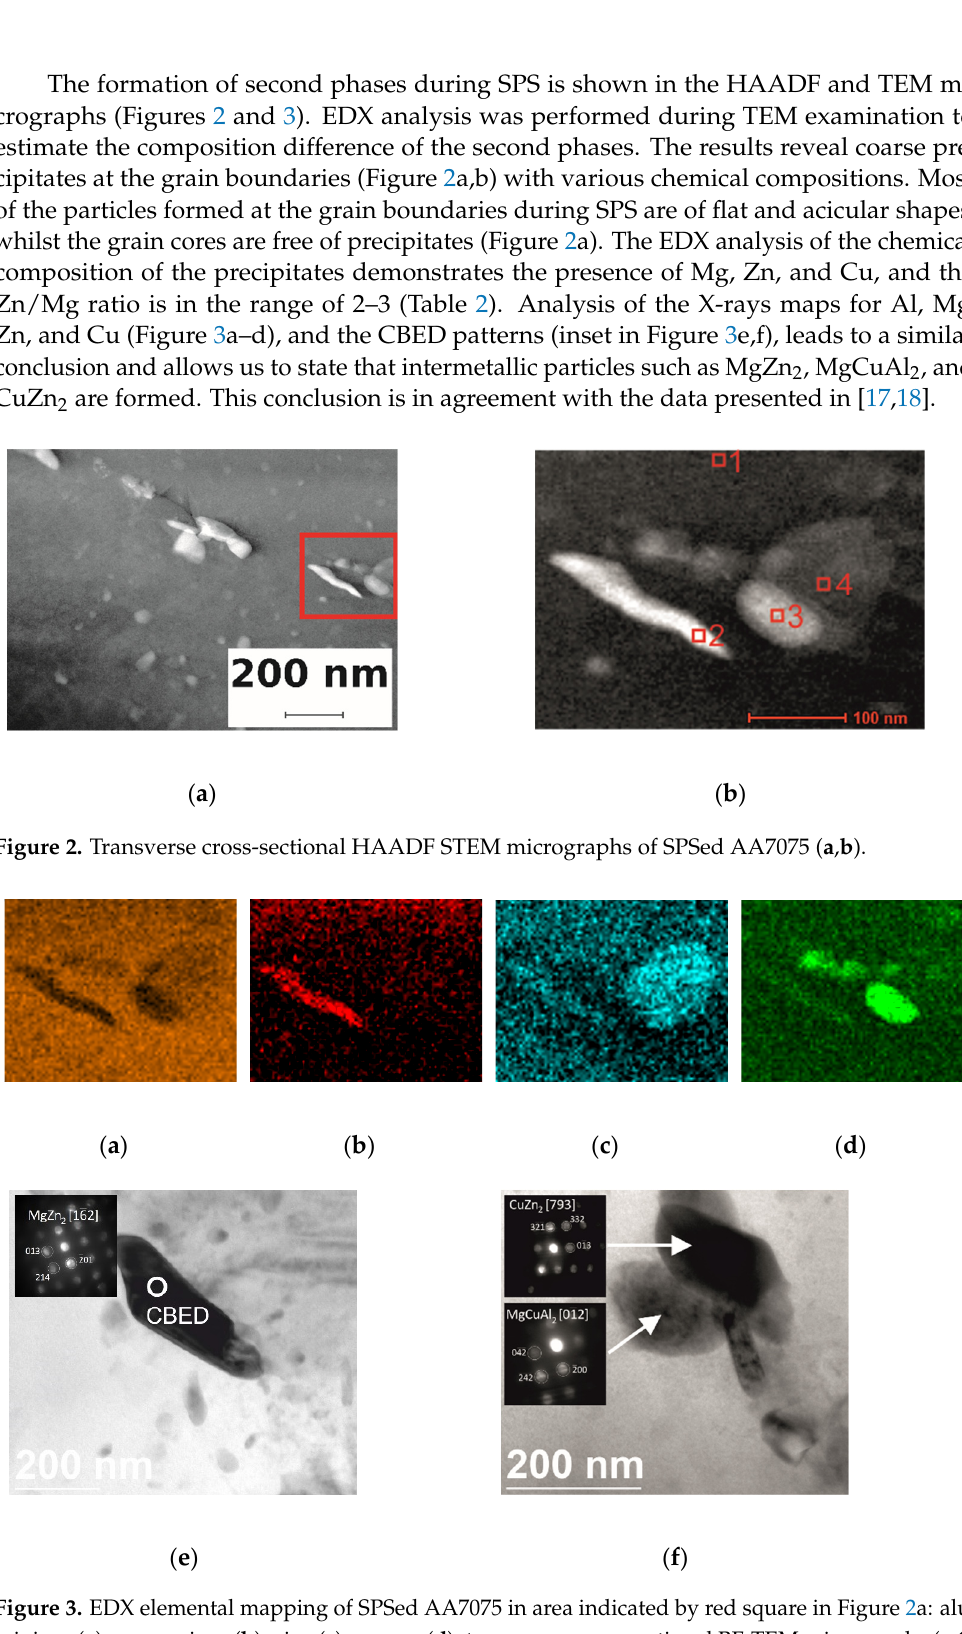
Figure 3. EDX elemental mapping of SPSed AA7075 in area indicated by red square in Figure 2a: aluminium ( a ); magnesium ( b ); zinc ( c ); copper ( d ); transverse cross-sectional BF-TEM micrographs ( e , f ). Insets of Figure 3e,f present CBED pattern of second phases.